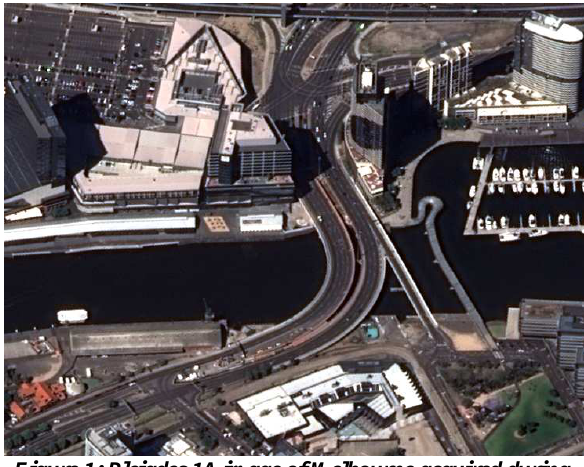
Figure 1: Pleiades 1A image of Melbourne acquired during